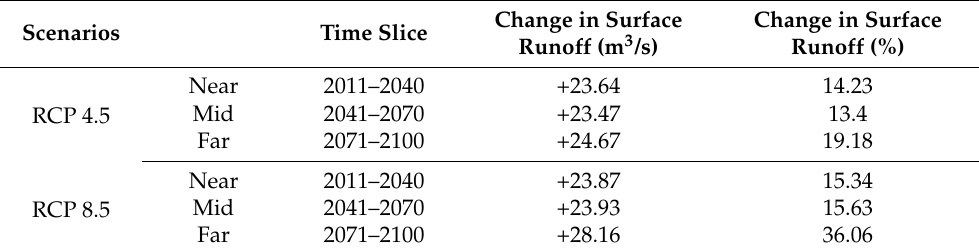
Table 6. Change in streamflow, due to climate change for RCP 4.5 and 8.5, as compared against the average value during the baseline period (1981 – 2010).